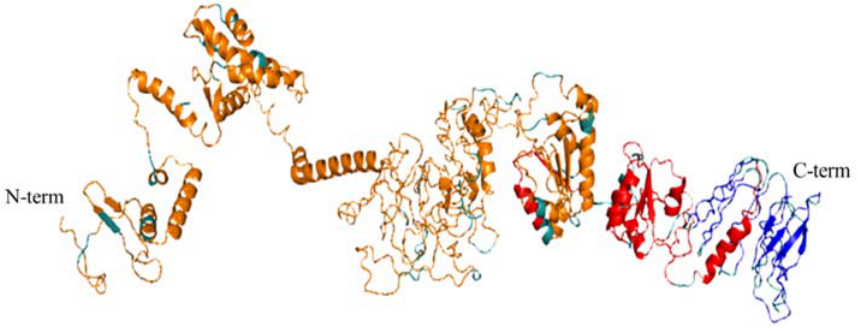
Figure 3. 3D model of the vaccine ensemble generated by RaptorX, respectively encompassing from the N ‐ term to the C ‐ term: B ‐ cell epitopes (orange), CD4 T ‐ cell epitopes (red), and CD8 T ‐ cell epitopes the N-term to the C-term: B-cell epitopes (orange), CD4 T-cell epitopes (red), and CD8 T-cell epitopes (blue). GGG linkers are shown in gray. (blue). GGG linkers are shown in